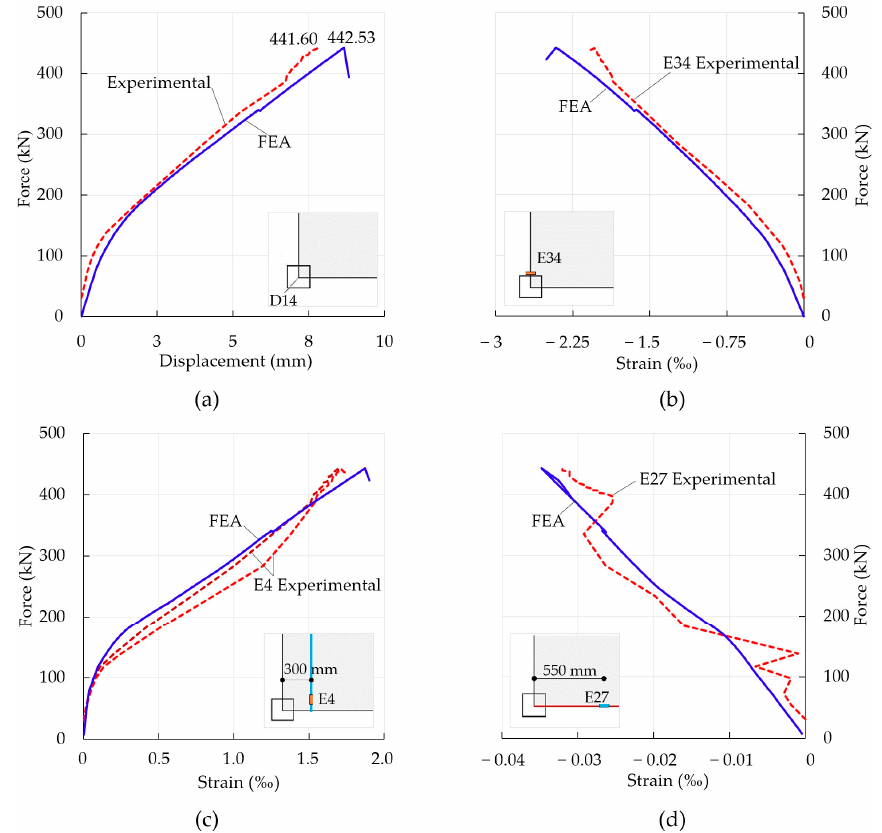
Figure 7. Comparison of numerical and experimental results of the M1 model.